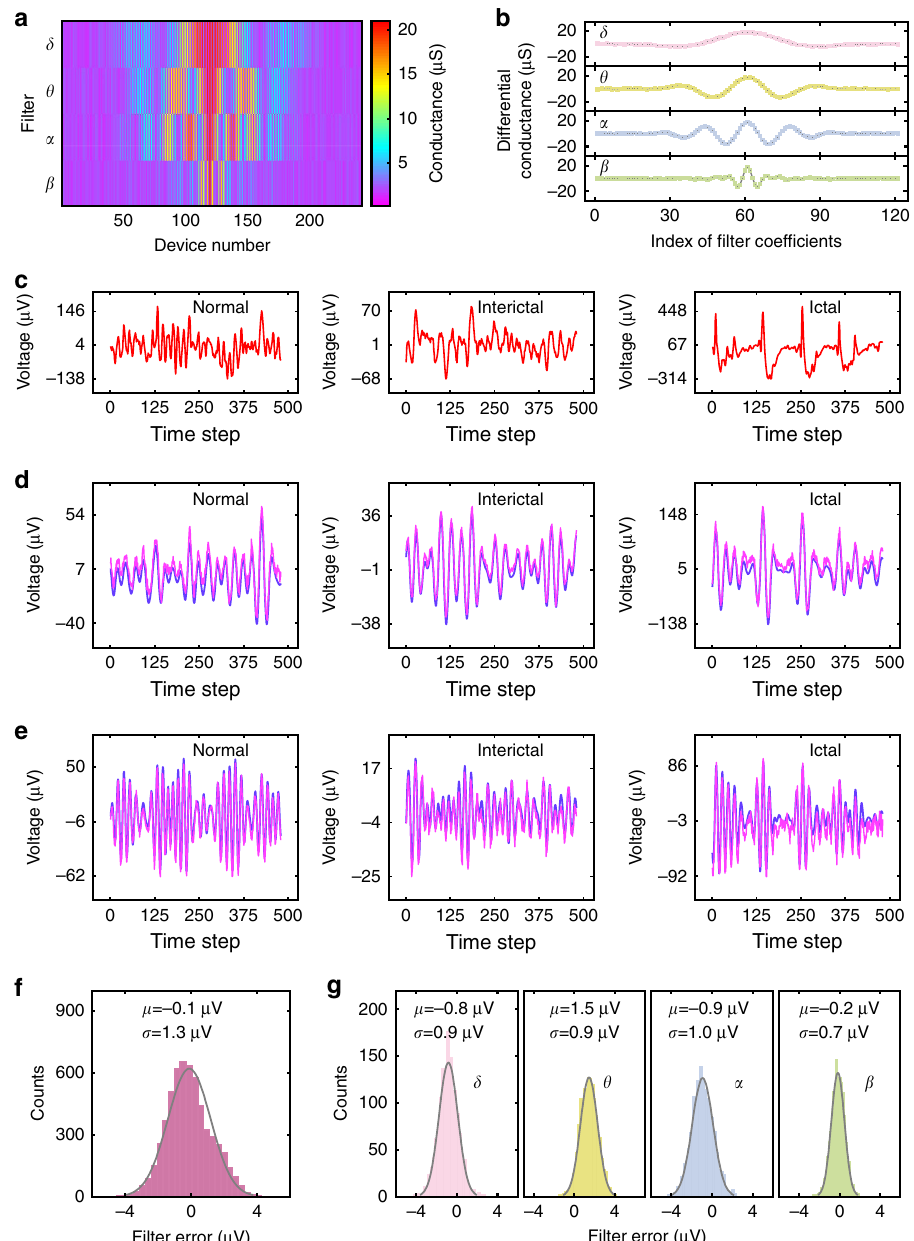
Fig. 3 Results of the memristor array-based neural signal fi lter bank. a Conductance map for the fi lter bank, and every column has 242 memristor devices for each 120-order fi lter. The fi lters δ , θ , α , and β are used to obtain the corresponding oscillatory waveforms. b Comparison of the mapped and target differential conductances for the fi lters δ , θ , α , and β in a . Software: gray lines. Measured: colored squares. c Typical epilepsy-related raw neural signals are fed as the input for the fi lter bank. d , e The fi ltered results of the fi lters θ and α , respectively, are shown as examples. The blue line represents software-calculated results and the purple line represents experimental results. The complete results for all the 4 fi lters are shown in Supplementary Fig. 6. f , g Error analysis between the software-calculated and the memristor array- fi ltered results. From left to right, the total error distribution f for all four fi lters and individual error distribution g for the fi lters δ , θ , α , and β are plotted, respectively. Here μ and σ are the mean and standard deviation, respectively. Source data are provided as a Source Data fi are labeled as “ normal ” , “ interictal ” , or “ ictal ” accordingly. Two samples. The identi fi cation accuracies of the neural networks with neural networks with the same structure are trained and tested on software-trained weights using dataset S (S.S.), software-trained both datasets. weights using dataset M (M.S.) and experimentally mapped Figure 4a shows the input feature vectors of 540 testing weights after training on dataset M (M.M.) are compared in samples. The memristor array-based neural network uses 126 Fig. 4d. As we can see, the M.S. simulation has achieved nearly devices to implement 63 synapses with differential weights, and the same accuracy as the S.S. simulation (95.78% ± 0.27% versus their conductance map after training on dataset M is shown in 96.41% ± 0.39%, both of which are averaged from 10 trials). This Fig. 4b. Figure 4c displays the output values for the 540 testing result af fi rms that the memristor array-based fi lter bank retains